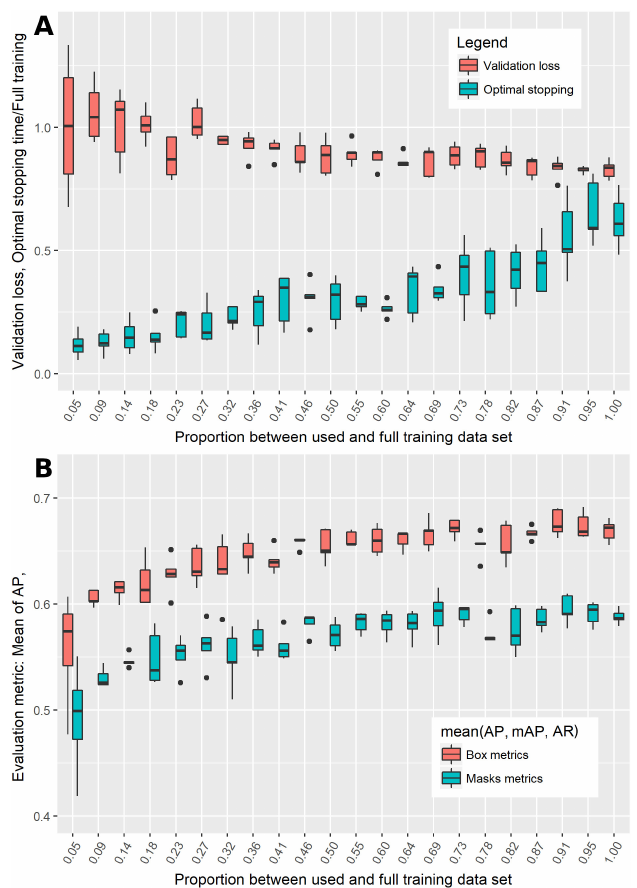
Figure 7. Boxplots for the Mask R-CNN performance depending on the size of the training data set. ( A ) validation loss and time for optimal stopping of model training; ( B ) mean of ‘averaged precision score’ (AP), ‘mean averaged precision score’ (mAP) and ‘averaged recall score’ (AR), mean(AP, mAP, AR) for the detection of bounding boxes and segmentation